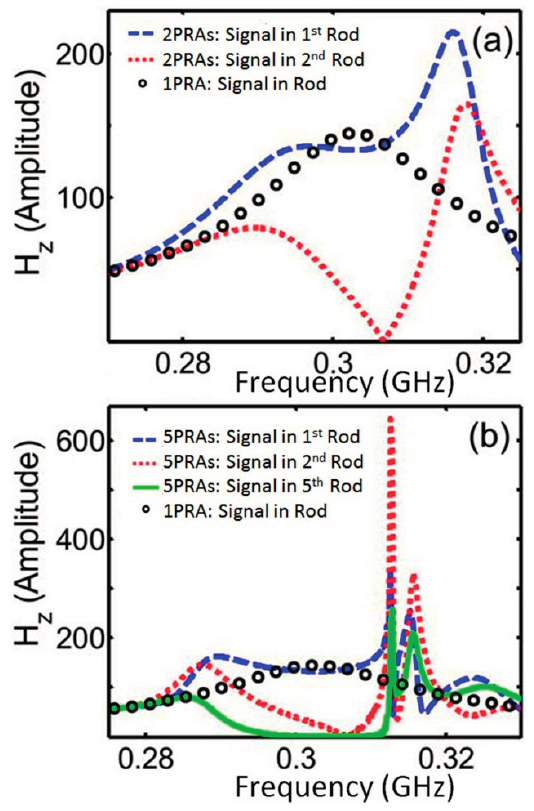
Figure 3. H-field probe spectra versus normalized frequency ( a / λ ) for a single PRA and arrays of ( a ) 2 and ( b ) 5 PRAs. Rod permittivity is